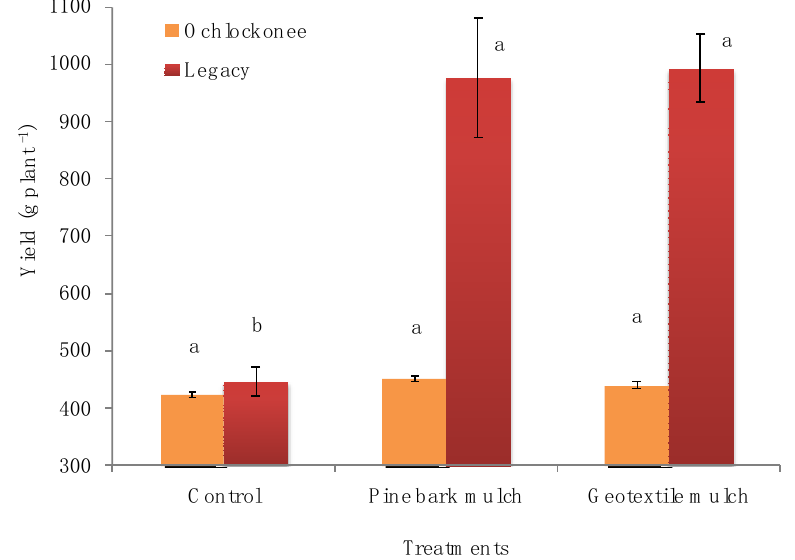
Figure 8. Effects of the different types of mulch on the yield per plant (kg plant − 1 ). For each cultivar, different lowercase letters indicate significant differences for different types of mulch, according to the Tukey test ( p < 0.05). The vertical bars correspond to ± the standard error of the mean ( n = 9).